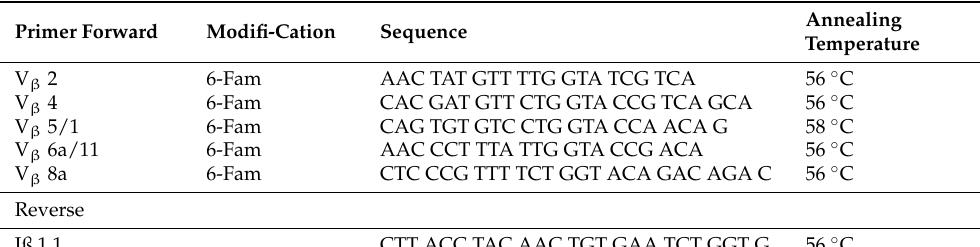
Table 1. Forward and reverse primer for V β -Spectratyping; sequences adapted from